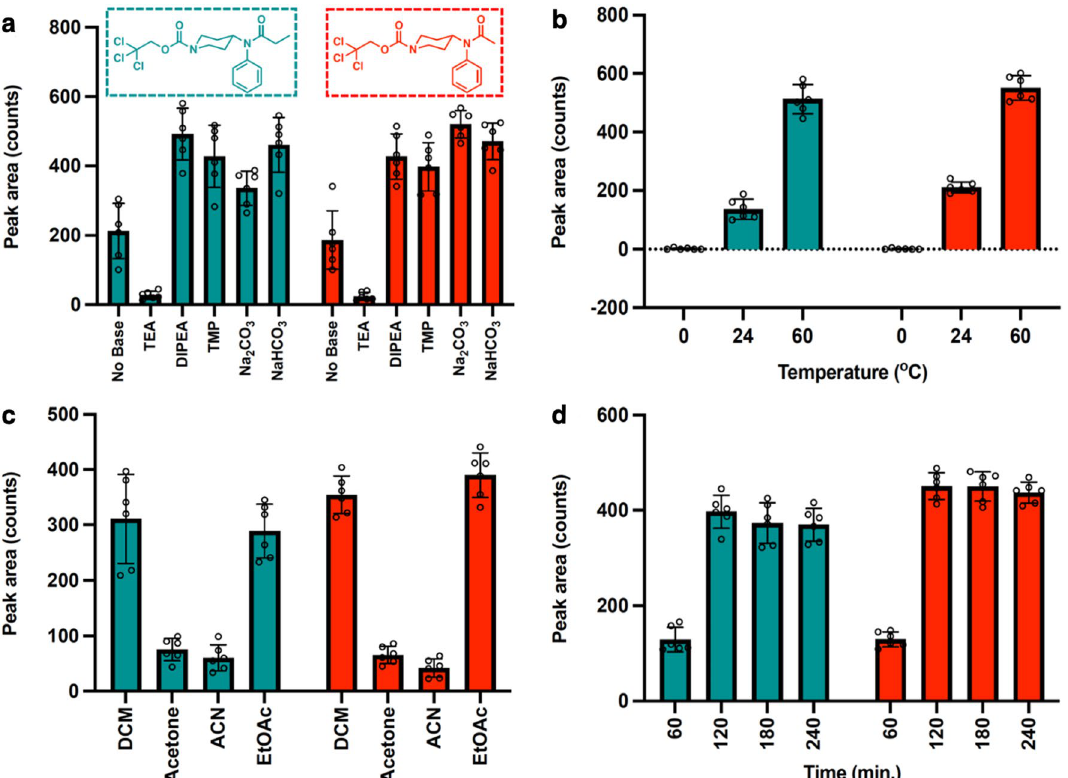
Figure 3. Optimization of reaction parameters for the reaction between fentanyl and acetylfentanyl with TrocCl (n = 6, ± standard deviation for each bar graph presented). ( a ) Effect of the nature of the base in the production of Troc-norfentanyl (teal bars) and Troc-nor-acetylfentanyl (red bars) at 60 °C at t = 3 h.; ( b ) effect of temperature on the reaction demonstrating the increase of the Troc-norfentanyl products as temperature is increased; ( c ) effect of solvent on the reaction showing its higher performance in DCM and ethyl acetate (EtOAc); ( d ) effect of time on the